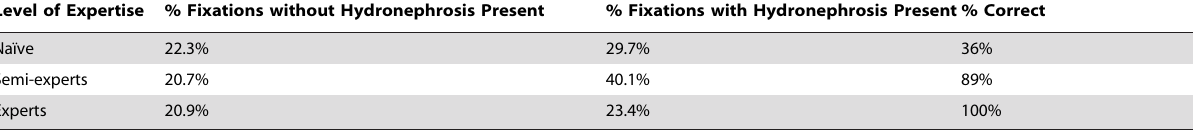
Level of Expertise % Fixations without Hydronephrosis